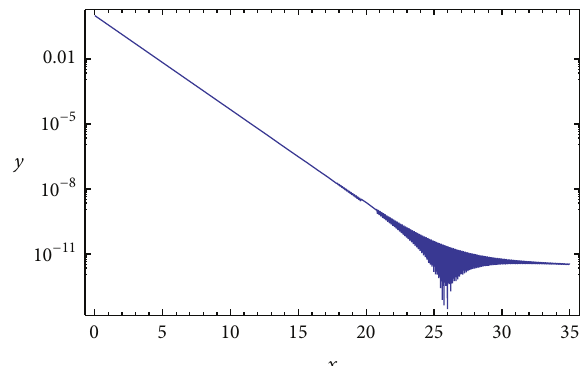
Figure 1: Decay curve obtained for 𝜔(𝑚) given by (6). Axes: 𝑦 = (𝑡) ,thelogarithmicscale; 𝑥 = 𝑡/𝜏 P 0